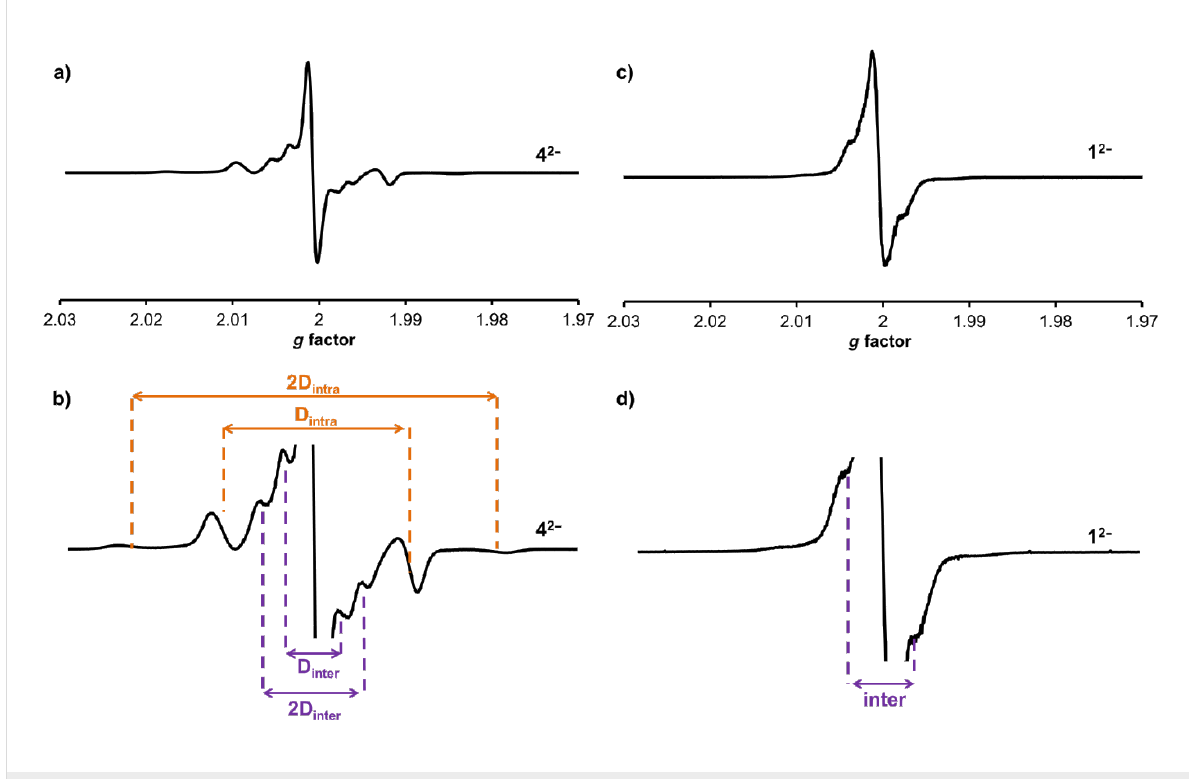
Figure 4: Frozen solution EPR spectra of triads 4 2 − (a) and 1 2 − (c), prepared by two electron reduction of 4 and 1 , respectively, at − 1.4 V recorded at 77 K in o -dichlorobenzene solution containing [ n -Bu 4 N][BF 4 ] as supporting electrolyte. Enlarged regions around the central feature of 4 2 − (b) and 1 2 − (d) show characteristic zero field splitting parameters for the intermolecular (purple) and intramolecular (orange) triplet states.